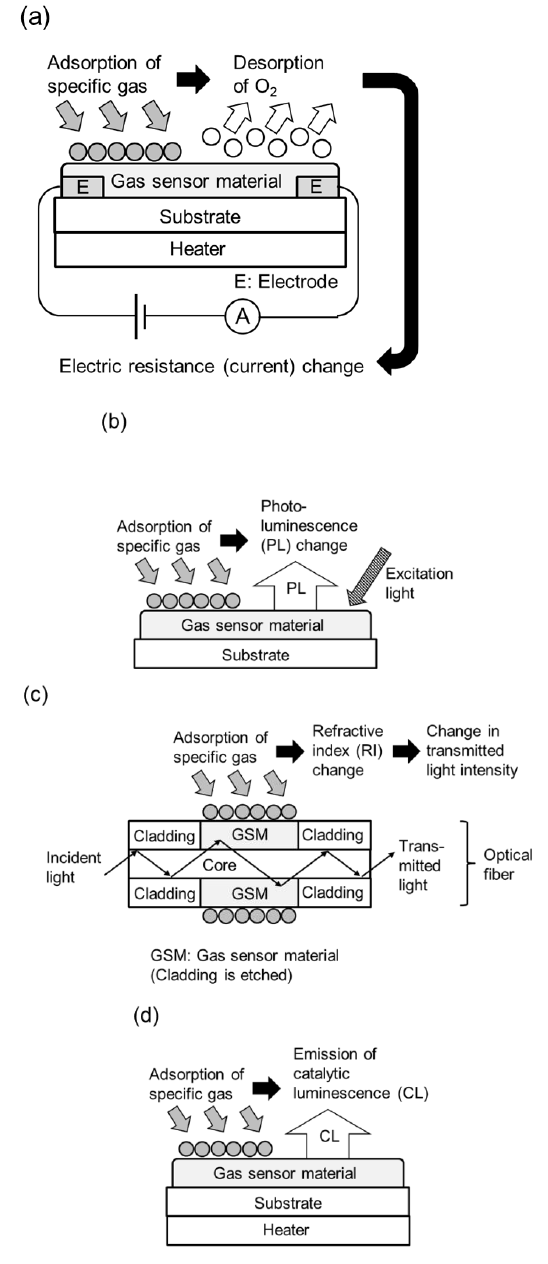
Figure 1. Schematic diagrams of conductometric and optical gas sensor configurations using CdS, CdSe, and CdTe. ( a ) Semiconductor gas sensor, ( b ) Optical gas sensor using PL characteristic change, ( c ) Optical gas sensor using refractive index change, and ( d ) Optical gas sensor using catalytic luminescence. Table 2. Conductometric and optical gas sensors using CdS, CdSe, and CdTe.